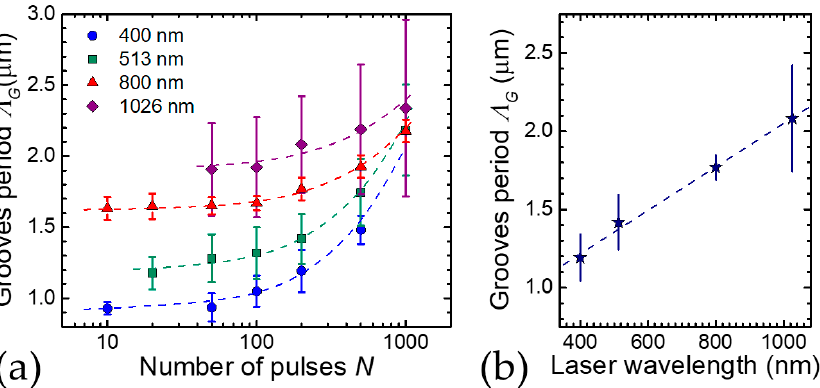
Figure 6. ( a ) Variation of the grooves period Λ G as a function of the number of pulses N for four different laser wavelengths. The data refer to laser surface texturing with Gaussian beams at different laser wavelengths: circles—400 nm ( ≈ 100 fs, F p = 0.27 J/cm 2 ) [31]; squares—513 nm ( ≈ 180 fs, F p = 0.4 J/cm 2 ) [34]; triangles—800 nm ( ≈ 35 fs, F p = 0.5 J/cm 2 ) [33]; diamond—1026 nm ( ≈ 180 fs, F p = 0.4 J/cm 2 ) [34]. The dashed lines represent linear fits to the experimental data (note that data are reported on a linear-log plot). ( b ) Grooves period vs. laser wavelength at N = 200 laser